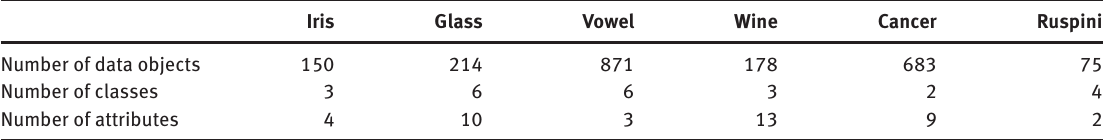
Table 1: Summary of Data